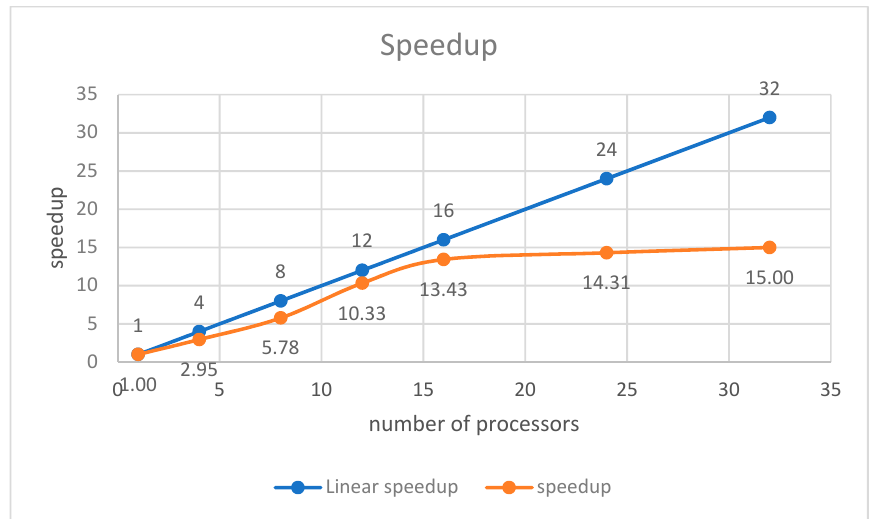
Figure 2. Speedup diagram.